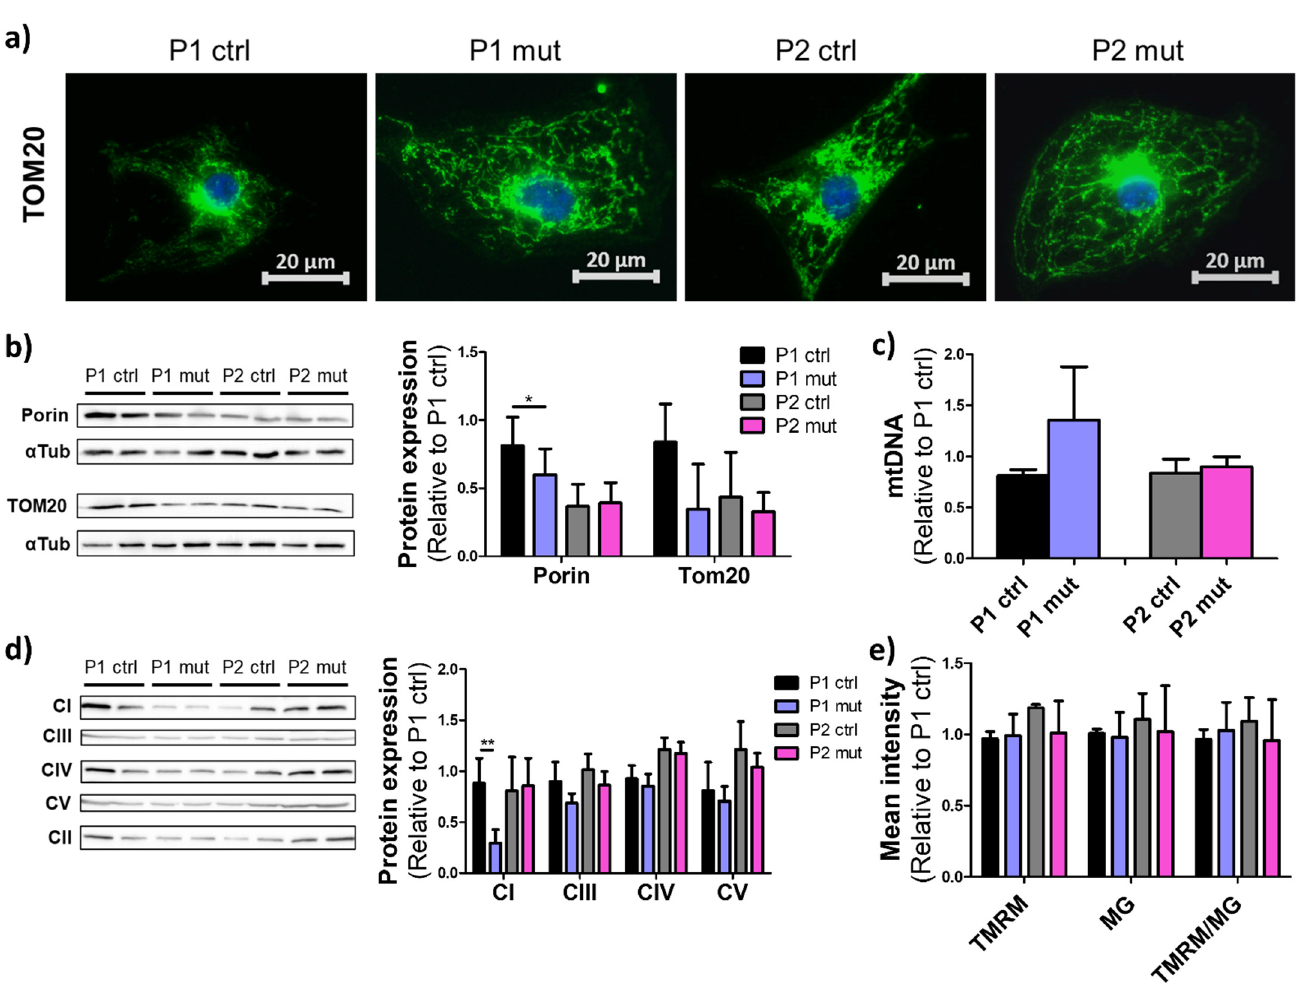
Figure 2. Mitochondrial mutations did not induce changes in mitochondrial mass or